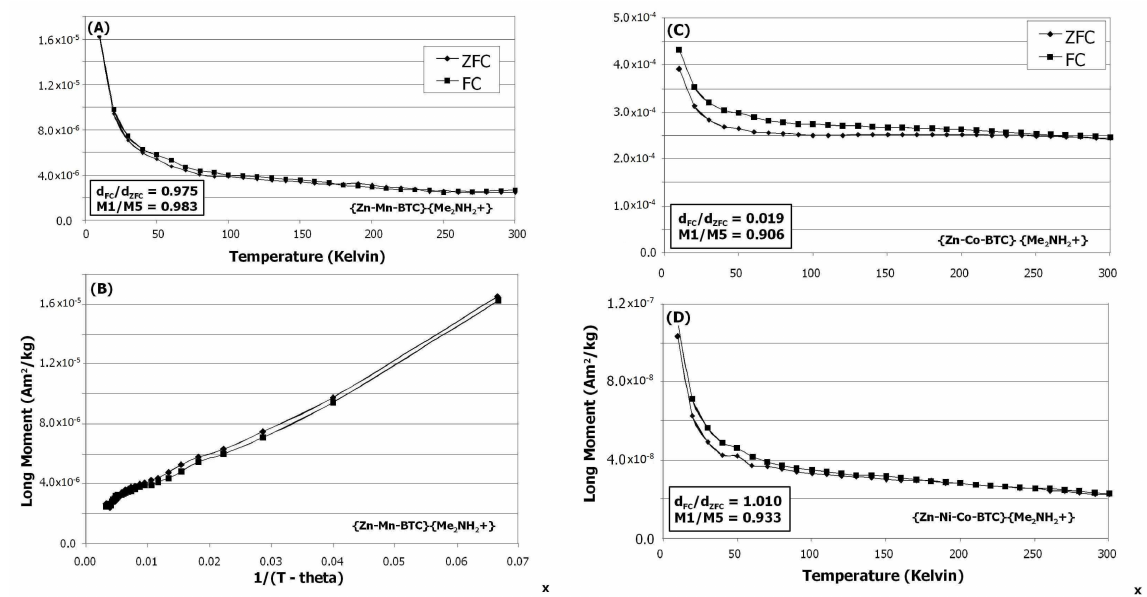
Figure 10. FC and ZFC within a constant applied field 0.001 T ROW experiments for {Zn-Mn-BTC}{Me 2 NH 2+ } ( A , B ); {Zn-Co-BTC}{Me 2 NH 2+ } ( C ); {Zn-Ni-Co-BTC}{Me 2 NH 2+ } ( D